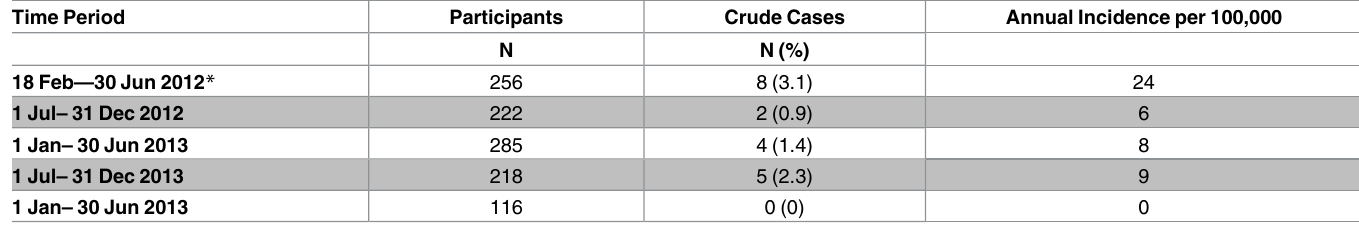
Table 6. Incidence of acute leptospirosis in six months intervals, Moshi Rural and Moshi Urban Districts, Tanzania,